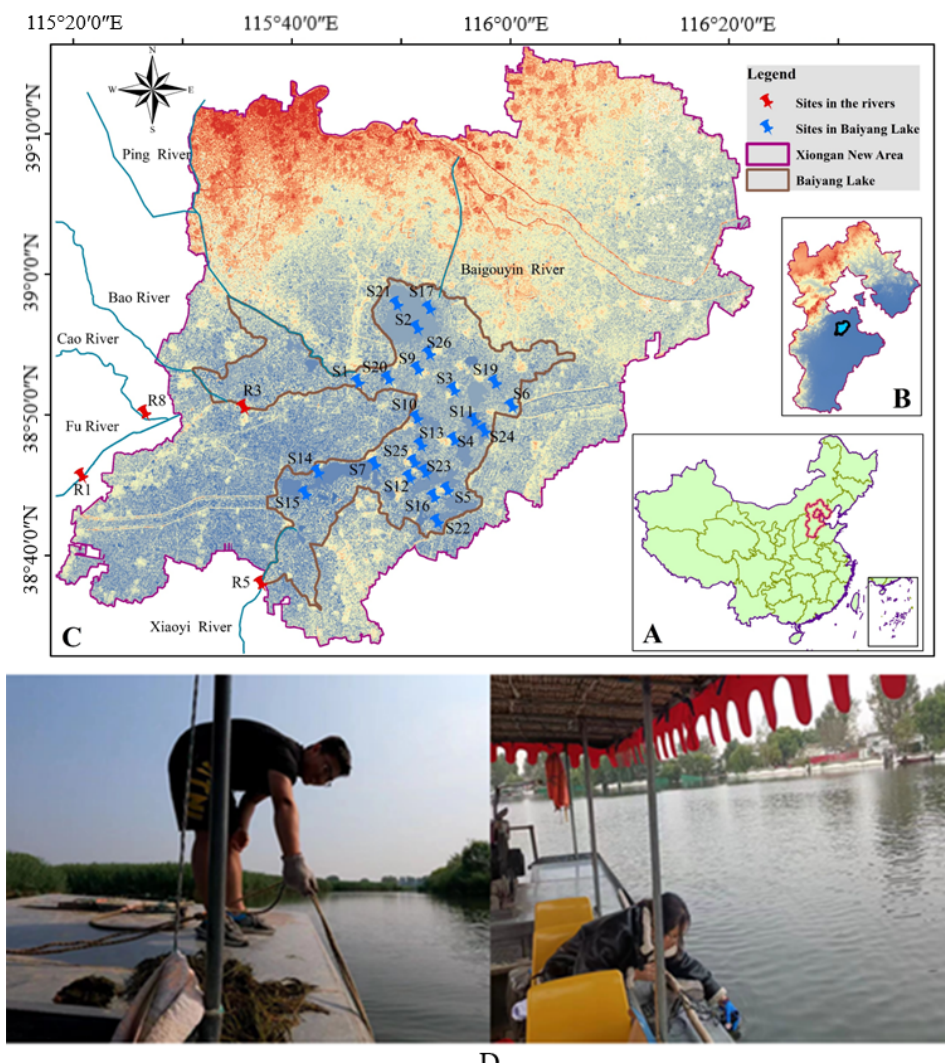
Figure 1. Locations of Hebei Province ( A ), Xiongan New Area ( B ), and sampling sites in Baiyang Lake and its upstream rivers ( C ), and the sampling was conducted in the field ( D ).